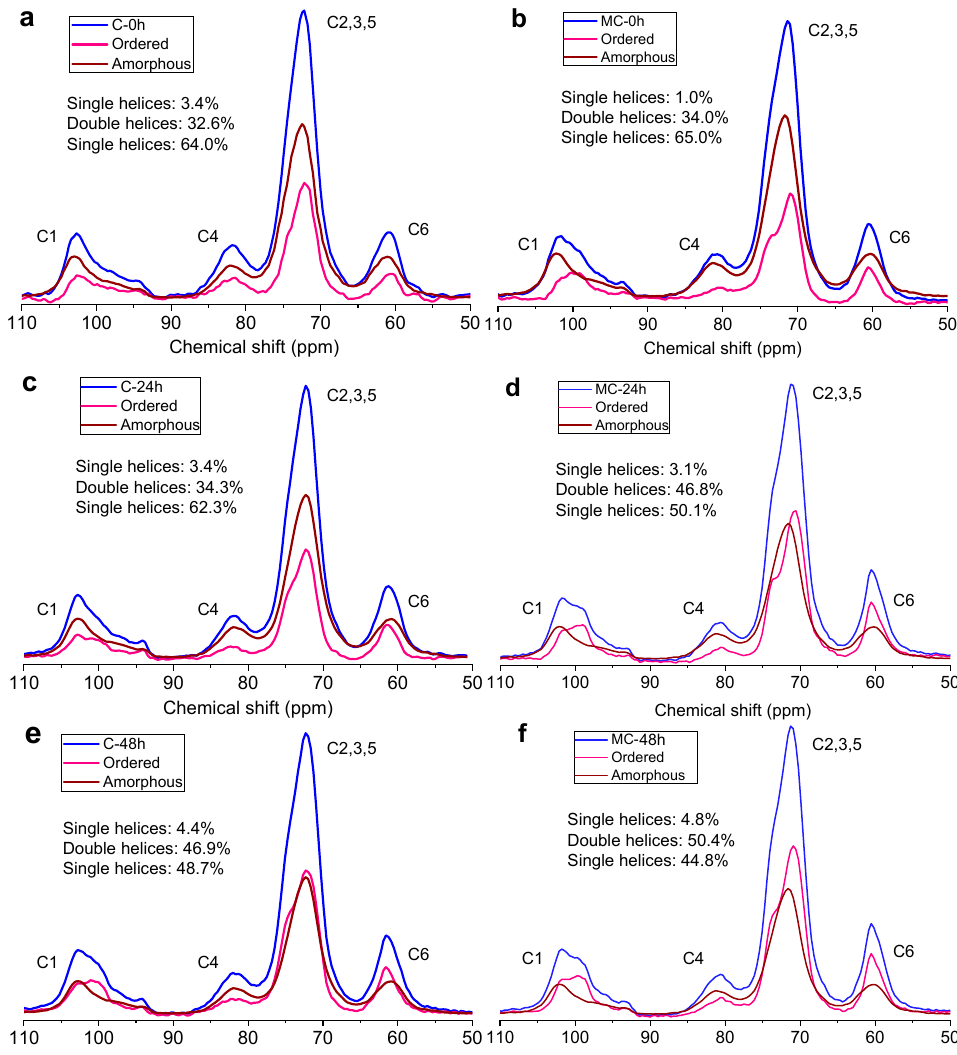
Figure 5. 13 C CP/MAS NMR curves of indica rice starch after conventional cooking (C) ( a , c , e ) and microwave cooking (MC) ( b , d , f ) at different storage times (0, 24, or 48 h).